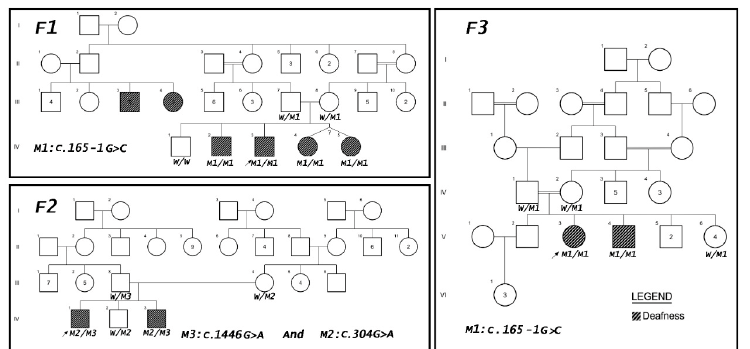
Figure 1. Pedigrees of the three investigated Jordanian families (F1, F2, and F3) with variants in SLC26A4 . Females are represented by circles and males are represented by squares. Filled symbols indicate affected individuals with hearing loss while empty symbols represent unaffected individuals. Arrows point to the proband of each family. The zygosity of the identified genotypes, validated using Sanger sequencing, was presented under the symbol of affected individuals and first-degree family members. Abbreviations: W: wild type, M1: mutation c.165-1G>C, M2: mutation (c.304G>A; p. Gly102Arg), and M3: mutation (c.1446G>A; p.Trp482*).